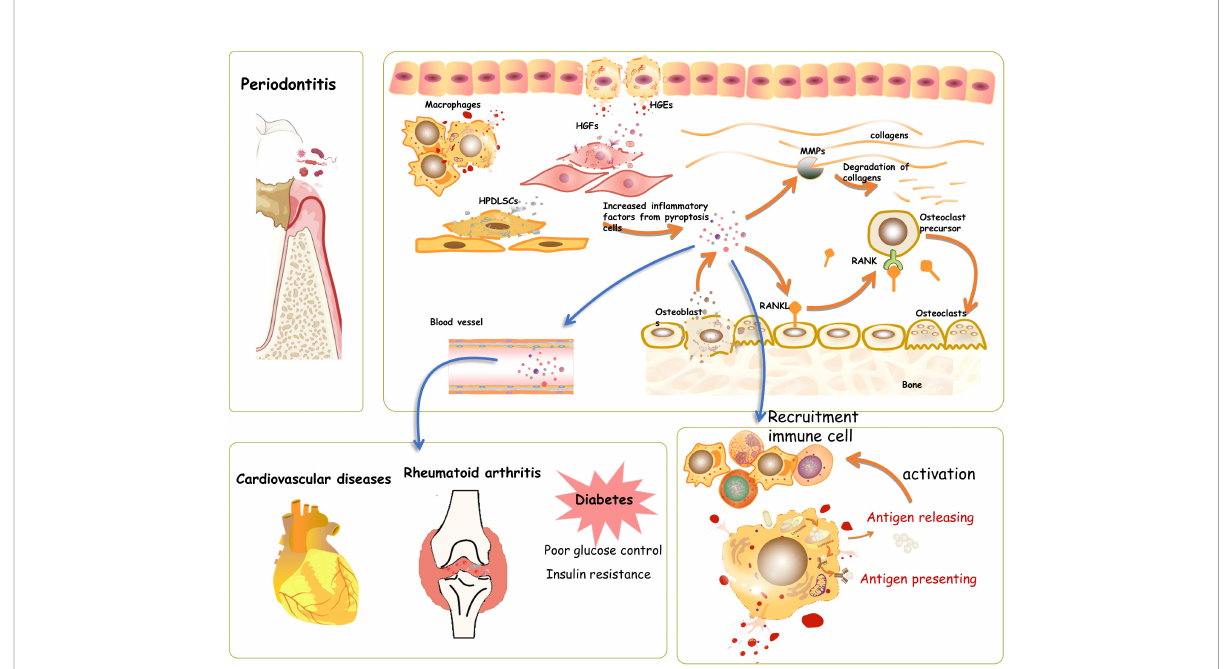
FIGURE 1 Pyroptosis in periodontal tissue. During the process of periodontitis, pyroptosis takes place in human gingival epithelial cells (HGEs), human gingival fi broblasts (HGFs), osteoblasts, and human periodontal ligament stem cells. The induced pyroptosis involves the activation and recruitment of immune cells, thus helping clear and prevent the spread of pathogens. However, the hyperactive and long-lasting pyroptosis would accelerate the process of periodontitis by increasing cell death and elevating in fl ammatory factors, which mediate the activation of oxygen species and matrix metalloproteinases, further causing connective tissue damage in periodontal tissue directly. The cascade ampli fi cation of the in fl ammatory response during pyroptosis might also contribute to the aggravation of systematic diseases, such as cardiovascular disease, diabetes, and rheumatoid